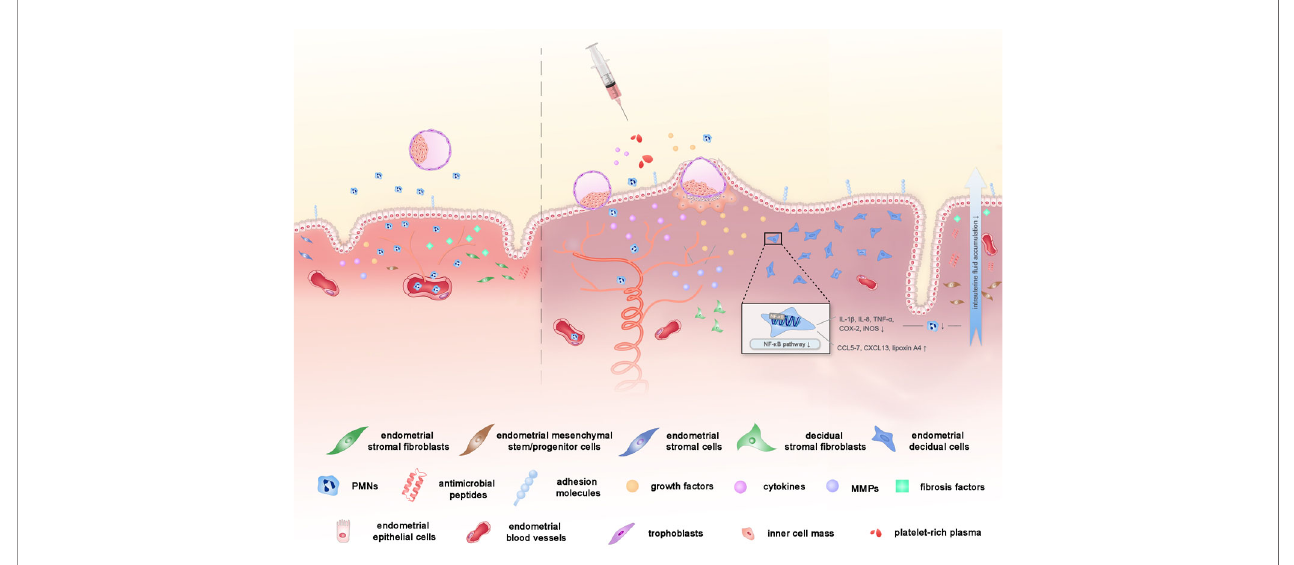
FIGURE 1 | The potential mechanisms of PRP on endometrial receptivity in assisted reproductive technology. PRP might improve the endometrial receptivity through the improvement of cell proliferation, vascularization, anti-in fl ammatory properties and the reduction in the degree of fi brosis, with the help of the concentrated peptides, GFs and cytokines in